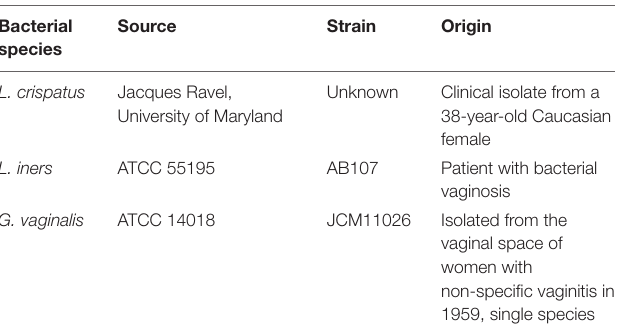
TABLE 1 | Bacterial species used in study